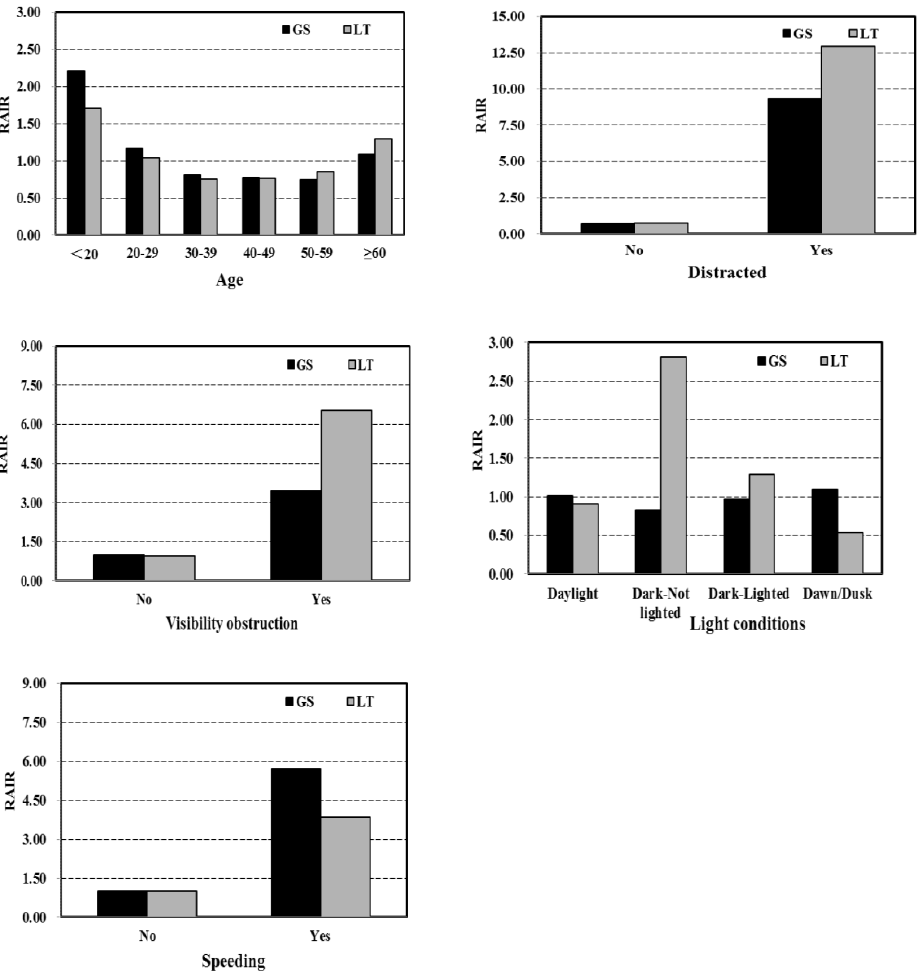
Figure 6. RAIRs for GS and LT groups under different conditions.